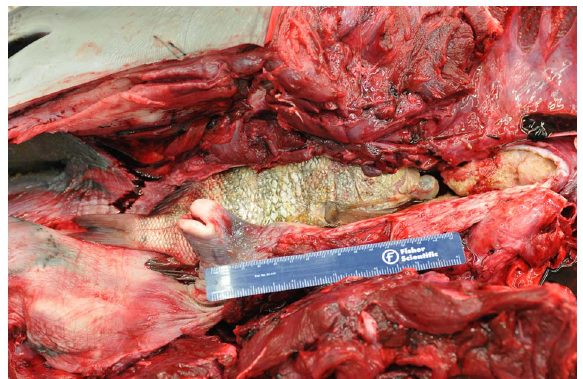
Figure 2. Photograph of stranded dolphin with fish. Photograph of IRL dolphin (Hubbs-0723) with sheepshead lodged in the esophagus.